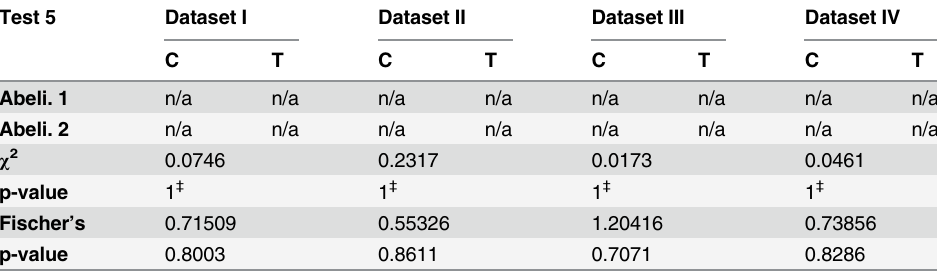
Table 6. Results of Chi-square Test 5 as presented by software R.